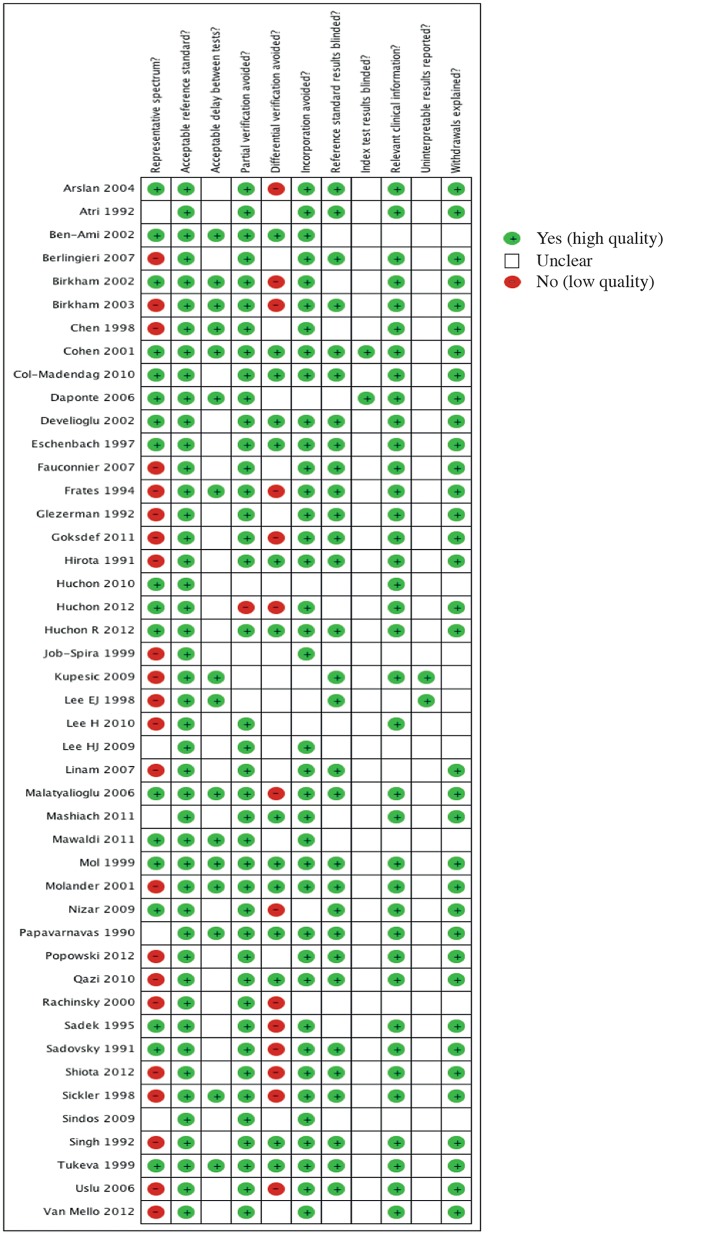
Methodological quality graph.Our judgements for each methodological quality item for all individual studies.